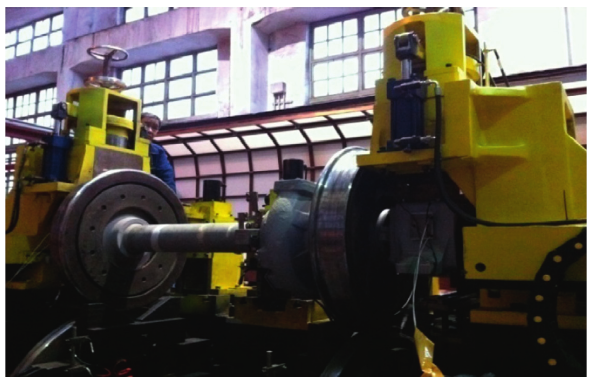
Figure 3: Experimental setup. Table 3: Description of bearing dataset.